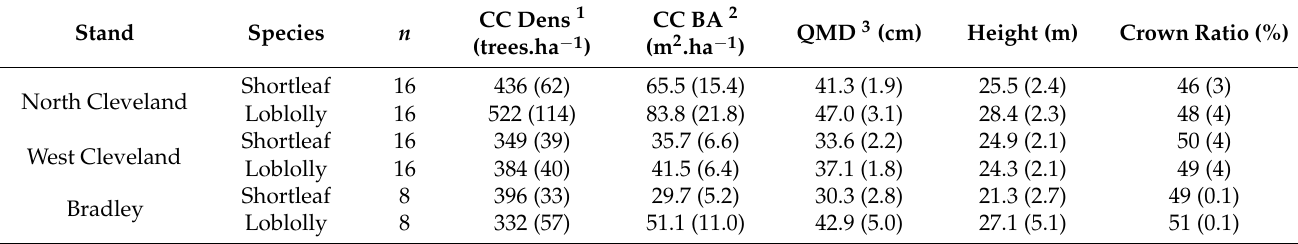
Table 3. Mean and standard error of competitor tree structural attributes in the neighborhoods of shortleaf and loblolly pine across three mature, natural-origin, pine–hardwood stands in southeastern Arkansas.